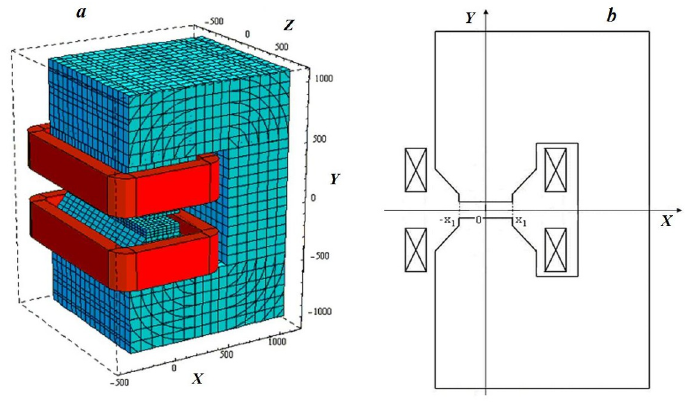
Figure 1. General view of the magnet (a) and its cut in the XOY plane